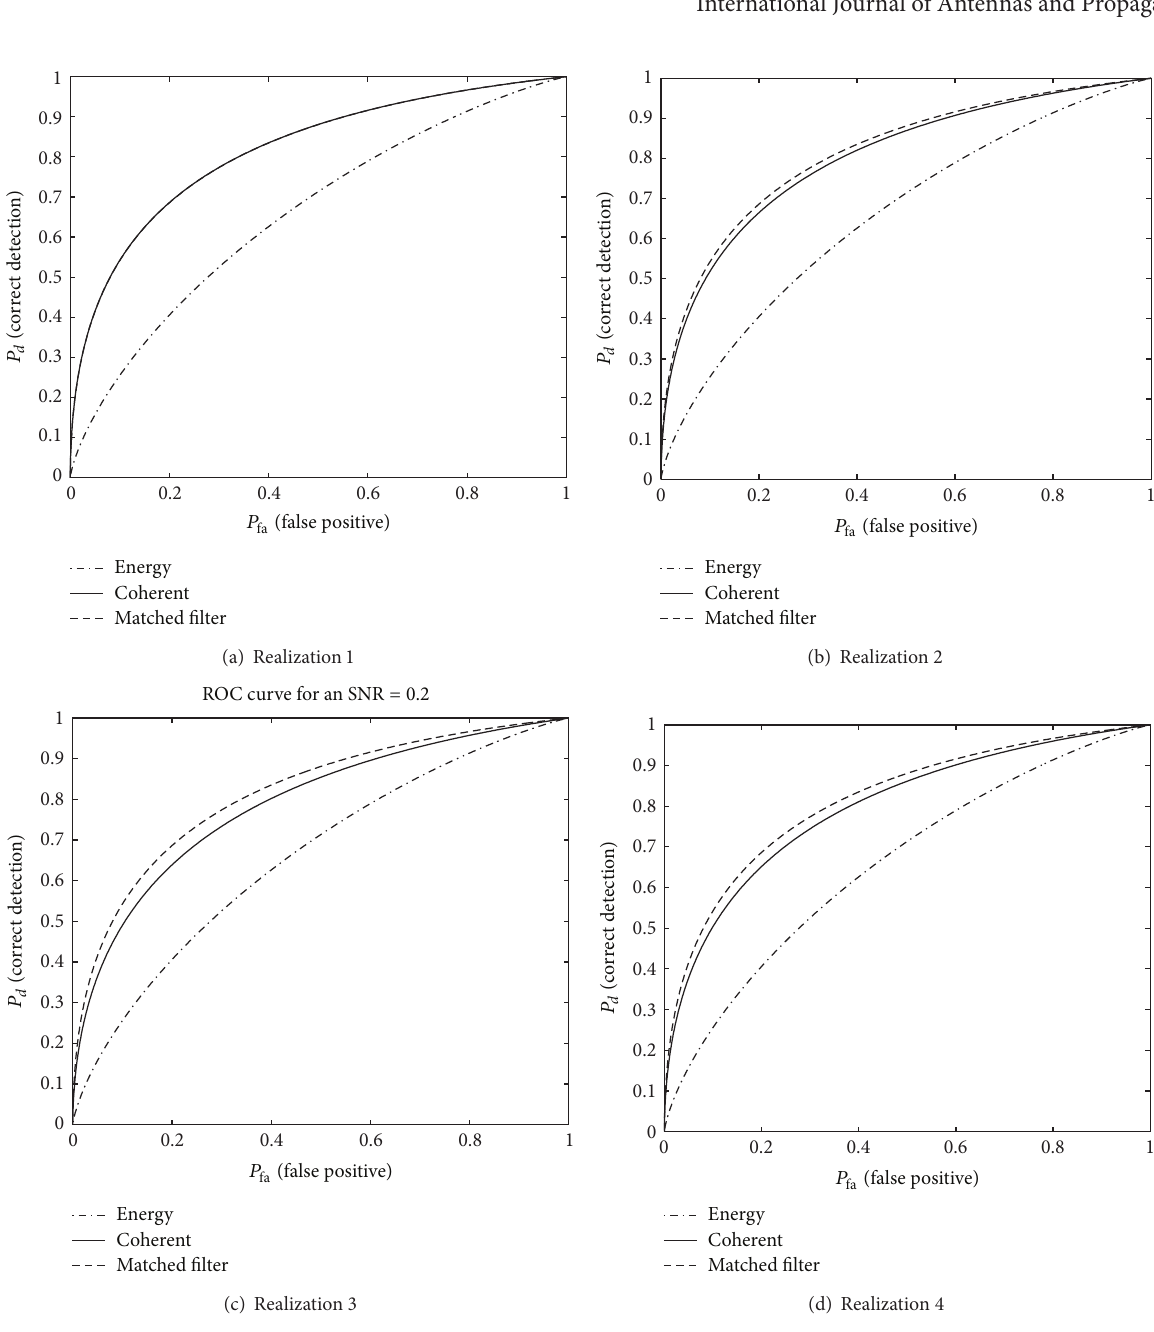
Figure 7: ROC curves for different realizations of the random